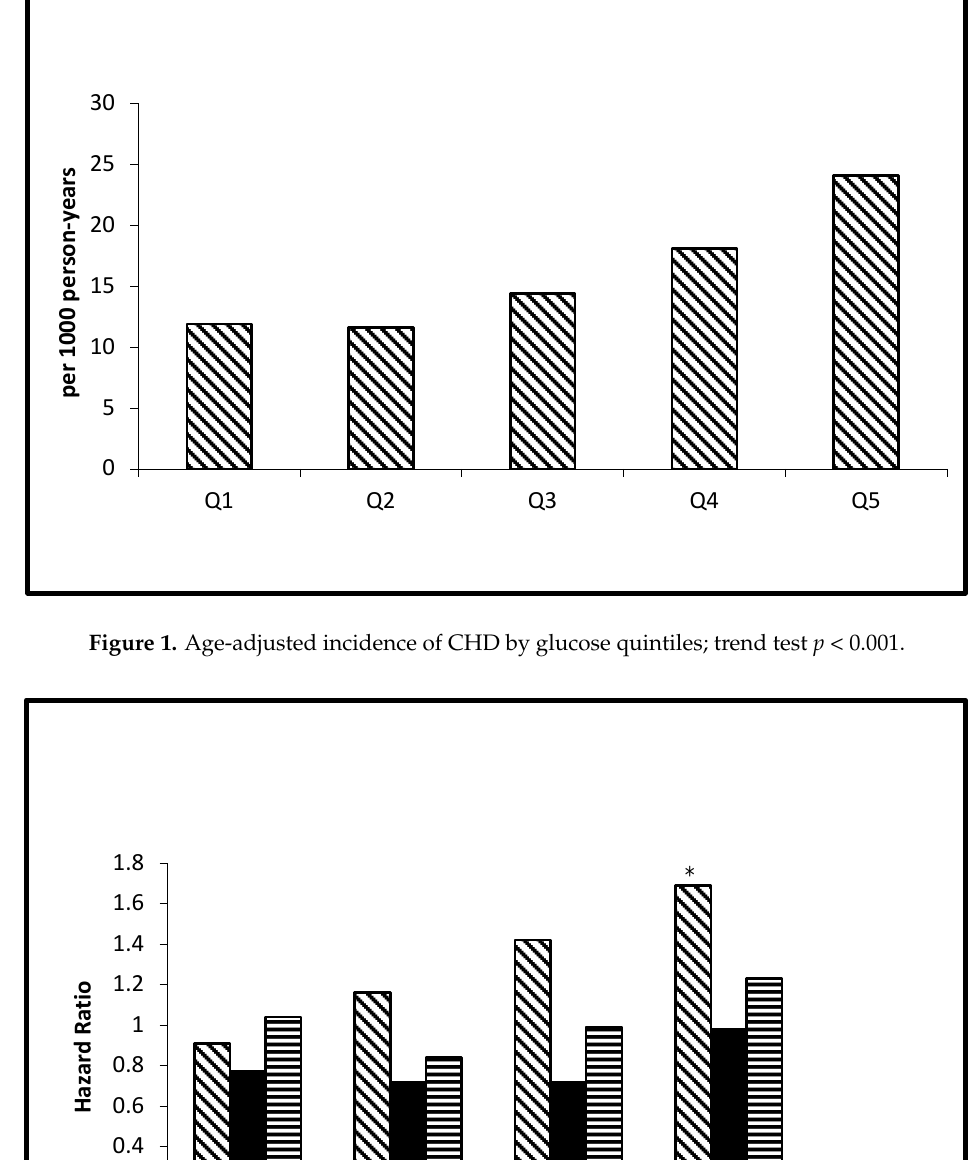
Figure 2. Risk of CHD by glucose, insulin and C-peptide quintiles from separate models. All models adjusted for age, hypertension, current and past smoking, total cholesterol, HDL-C, triglycerides, physical activity, alcohol consumption, body mass index; * p = 0.02. Test for trend adjusted for risk factors; glucose p = 0.004; insulin p = 0.96; C-peptide p = 0.47.